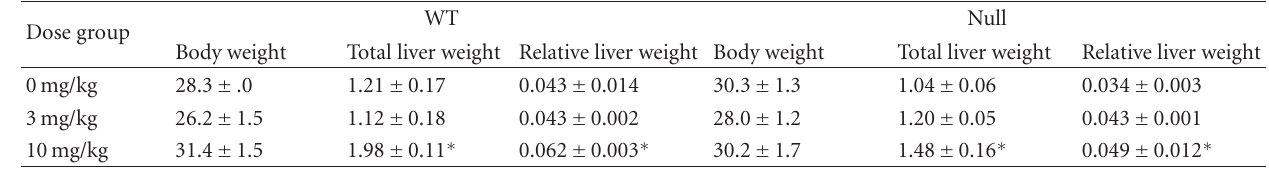
Table 1: Average body weight and liver weight of control and PFOS-treated mice on the day of tissue collection . 1